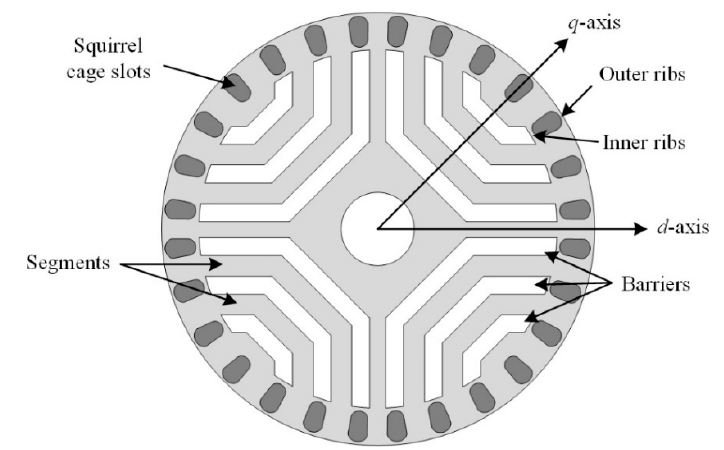
Figure 1. Rotor structure of the line-start synchronous reluctance motor (LS-SynRM).